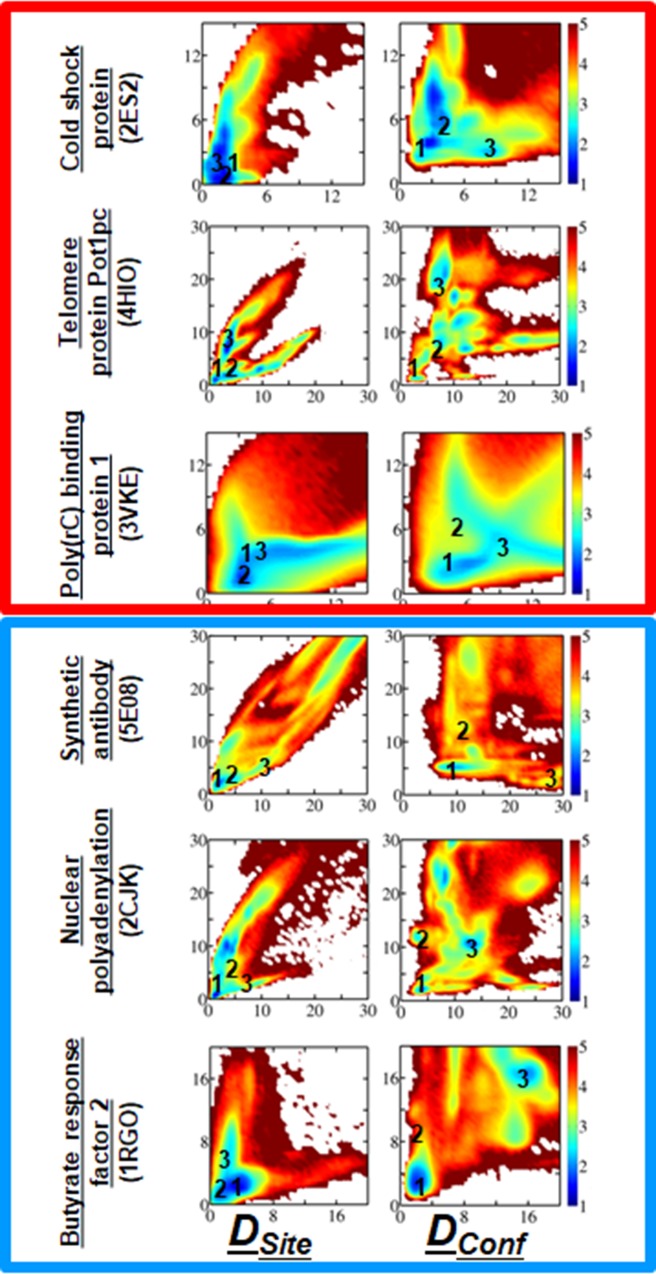
Conformational ensemble of predicted structures of proteins with single-stranded nucleic acids.The population distribution of predicted conformations is shown for ssDBP–ssDNA (top, red square) and ssRBP–ssRNA (bottom, blue square) complexes. The simulated structures are quantified by two similarity parameters, DSite and DConf. Whereas DConf quantifies the conformational similarity between the predicted and experimental interface considering ssDNA/ssRNA direction, DSite quantifies their overall conformational similarity without considering ssDNA/ssRNA direction. Accordingly, Dsite mostly highlights the accuracy of the predicted binding patch of the protein and Dconf also sheds light on the specificity of interactions at the interface between the protein and the ssDNA/ssRNA (see Methods). To rank each predicted conformation by its similarity to the experimentally determined structure, the interface was divided into two moieties (1 and 2) and the deviation of each moiety from the corresponding region of the experimental structure was measured. A lower value of Dconf (or of Dsite) corresponds to a conformation having a greater degree of similarity to the experimental structure, whose DSite values (D1Site, D2Site) and DConf values (D1Conf, D2Conf) are (0,0). The colour bar shows the free energy of the different binding conformations of the complex, where the scale ranges from blue (low energy, densely populated) to red (high energy, sparsely populated). Representative conformations from three regions marked 1–3 in the current figure are shown in Fig 4. Additional molecular and structural details for each of the complexes can be found in Table 1.